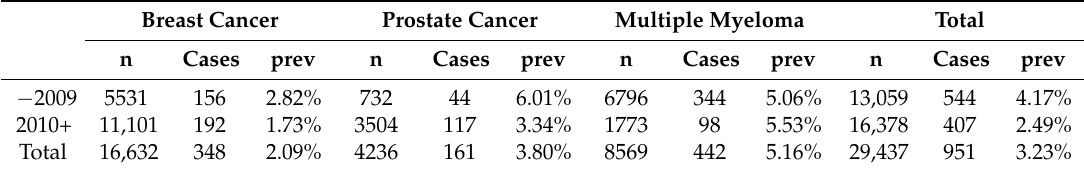
Table 2. Weighted prevalences in breast cancer, prostate cancer, and multiple myeloma patients.